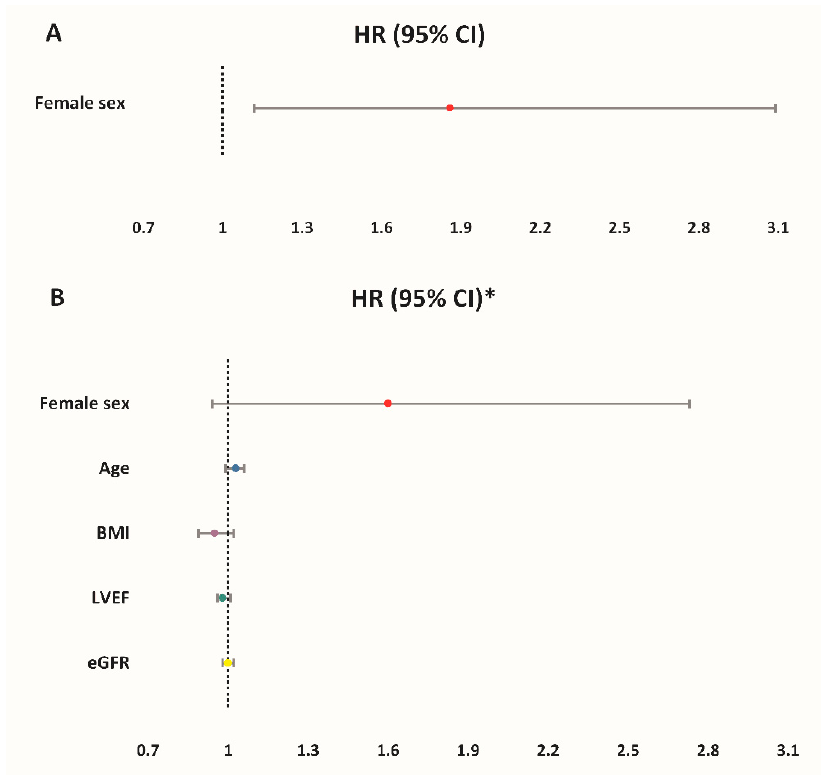
Figure 2. Hazard ratios (HR) of MACCE for different predictors: ( A ) Unadjusted rates; ( B ) Adjusted rates. * Multivariate Cox regression model-reference groups for categorical variables: male sex; no diabetes mellitus. Legend: MACCE, major adverse cardiovascular and cerebrovascular events (composite of cardiac mortality, ischemic stroke, urgent coronary revascularization and nonfatal myocardial infarction); LVEF, left ventricular ejection fraction; eGFR, estimated glomerular filtration rate; BMI, body mass index; RBC, red blood cells.